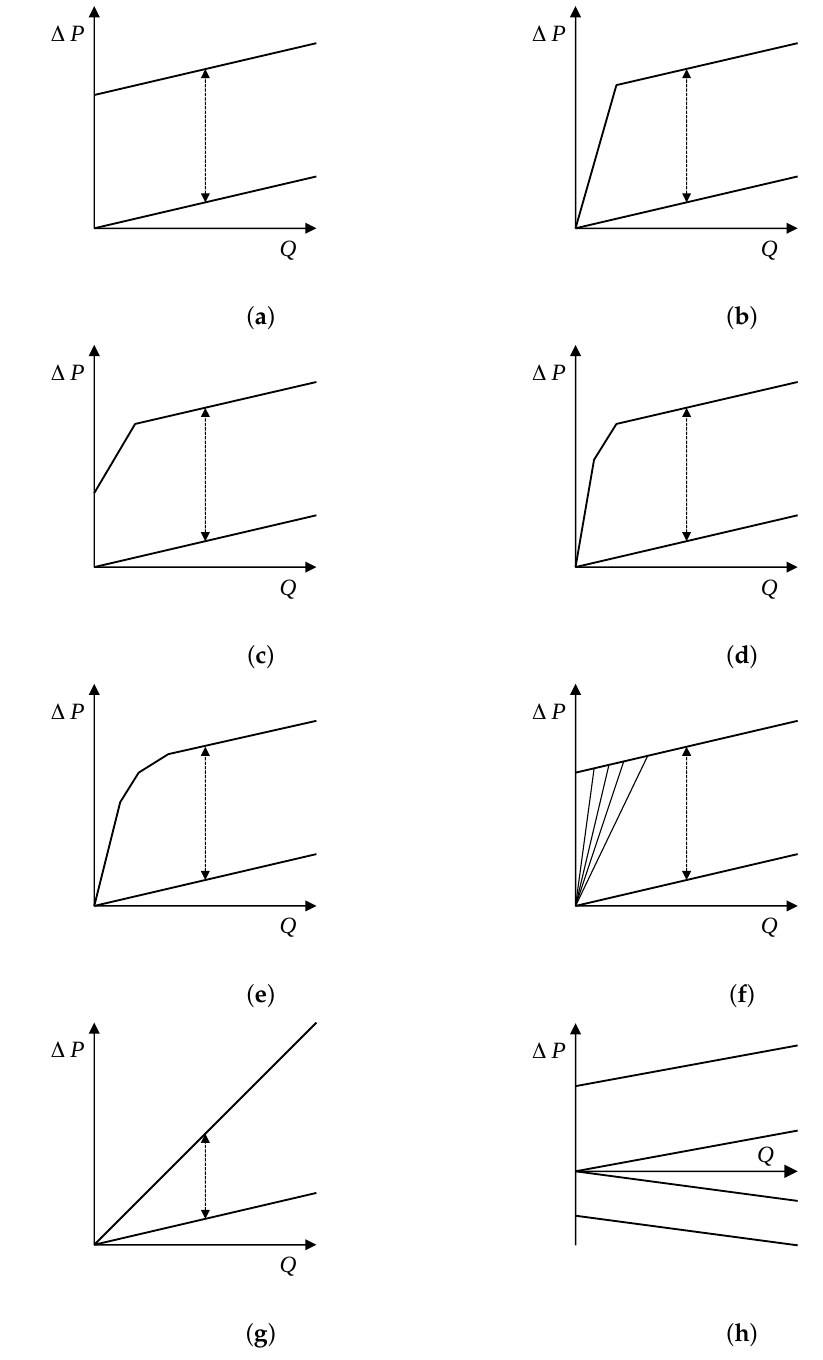
Figure 9. Steady-statepressure-flow rate ∆ P − Q characteristics (envelopes) of MR valves: ( a ) benchmark, no bypass, ( b ) benchmark, hydraulic bypass, ( c ) benchmark, flux bypass, ( d ) benchmark & hybrid hydraulic and flux bypass, ( e ) parallel flow channels, ( f ) variable slope bypass—1, ( g ) variable slope bypass—2, ( h ) asymmetric